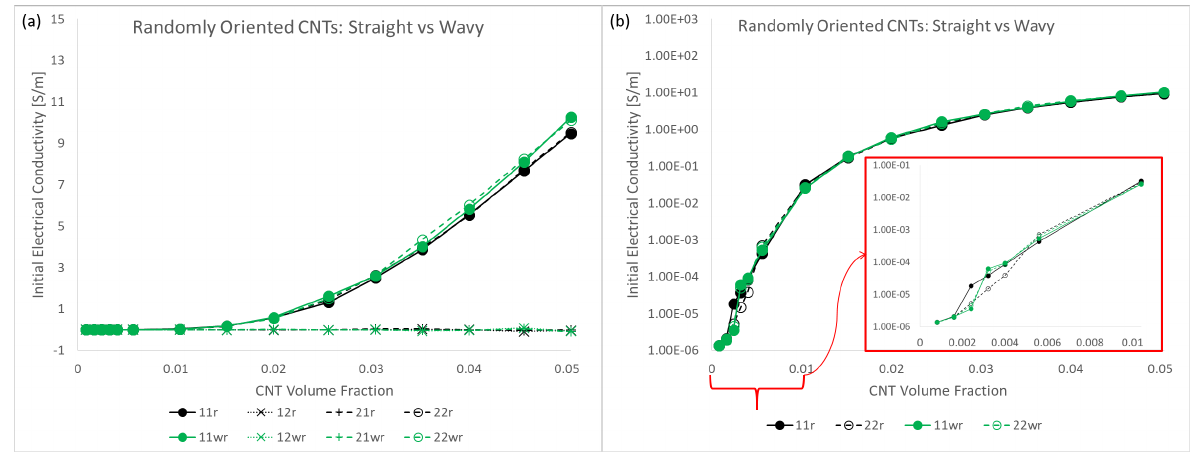
Figure 28. ( a ) Mean of all initial electrical conductivity terms Σ ij and ( b ) mean of Σ 11 and Σ 22 on a semi-log scale for the randomly oriented straight (r) and randomly oriented wavy cases (wr).